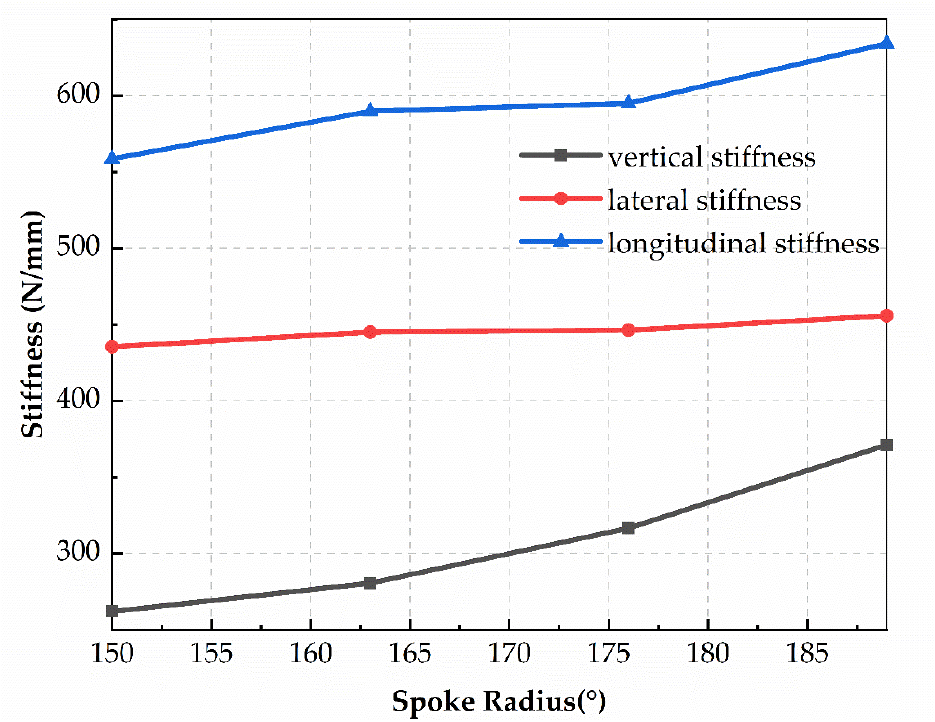
Figure 10. Effects of the spoke radius on the three-dimensional stiffnesses of the FS-NPT. In the longitudinal and vertical direction, the spoke had a trend of buckling. The bigger the radius, the less the initial buckling trend. Hence, the increase in spoke radius had a positive effect on both longitudinal stiffness and vertical stiffness, and the load-carrying capacity of the FS-NPT